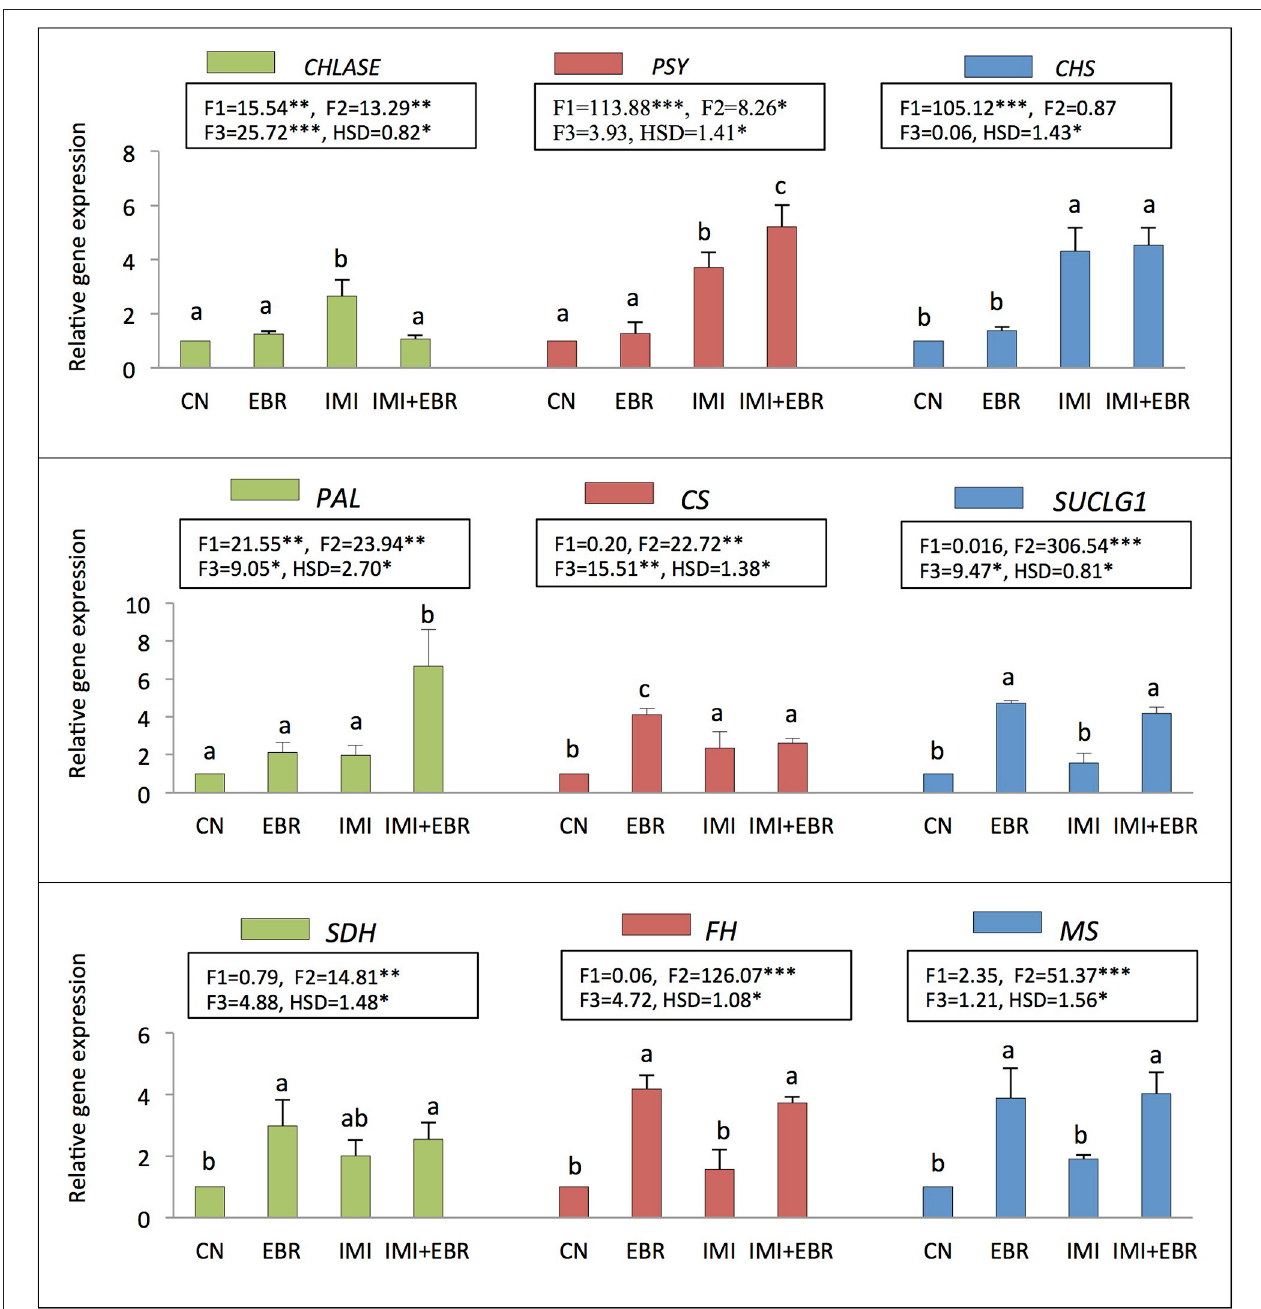
FIGURE 2 | Effect of seed soaking with 24-epibrassinolide (EBR) on gene expression of Brassica juncea seedlings grown under imidacloprid (IMI) toxicity. Data are mean ± standard deviation, two-way ANOVA and Tukey’s HSD (three biological replicates). Treatments with same letter indicates no significant difference at p < 0.05. F1, F2, and F3 are F-ratios for IMI, EBR, and IMI × EBR, respectively. CN, control; EBR, 100 nM EBR; IMI, 200mg IMI/L DW; CS, citrate synthase; SUCLG1, succinyl Co-A ligase; SDH, succinate dehydrogenase; FH, fumarate hydratase; MS, malate synthase; CHLASE, chlorophyllase; PSY,